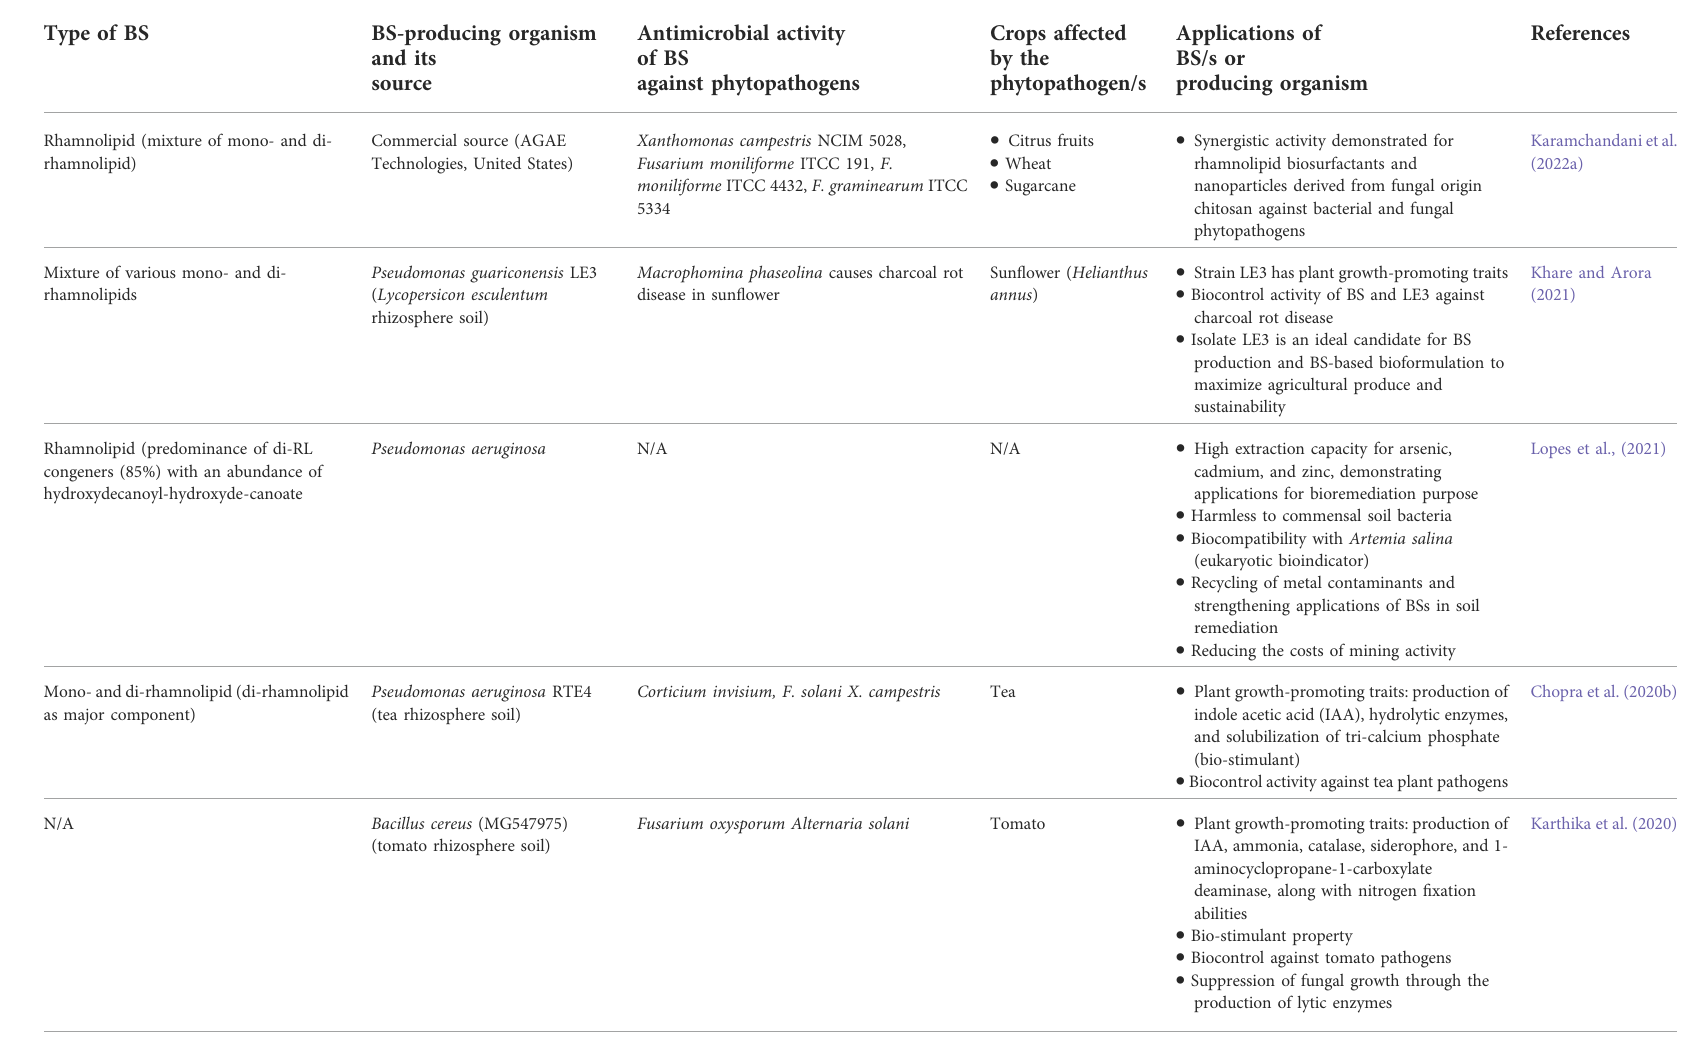
TABLE 1 Agriculture-related applications of biosurfactants in controlling phytopathogens and